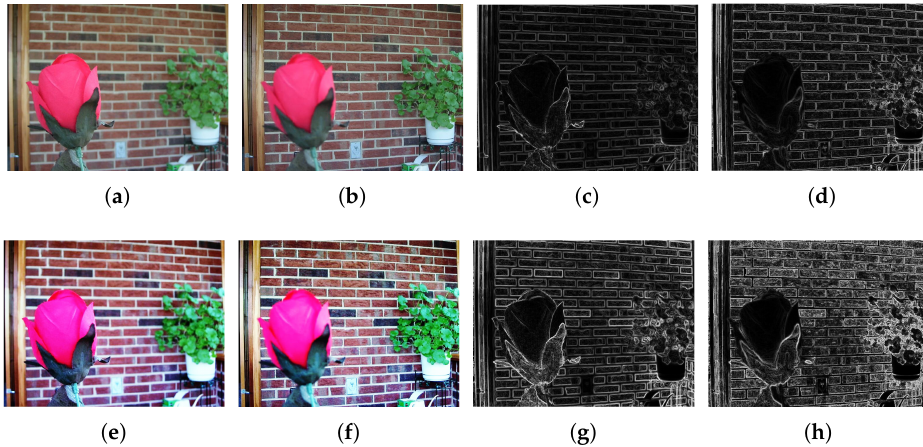
Figure 2. Results of edge detection after contrast enhancement. ( a ) Near focus image, ( b ) far focus image, ( c , d ) gradients of ( a , b ) achieved by a spatial stimuli sketch model (SSGSM) [26], ( e , f ) contrast enhancement using non-parametric modified histogram equalization (NMHE) [25], ( g , h ) gradients of ( e , f ) achieved by SSGSM